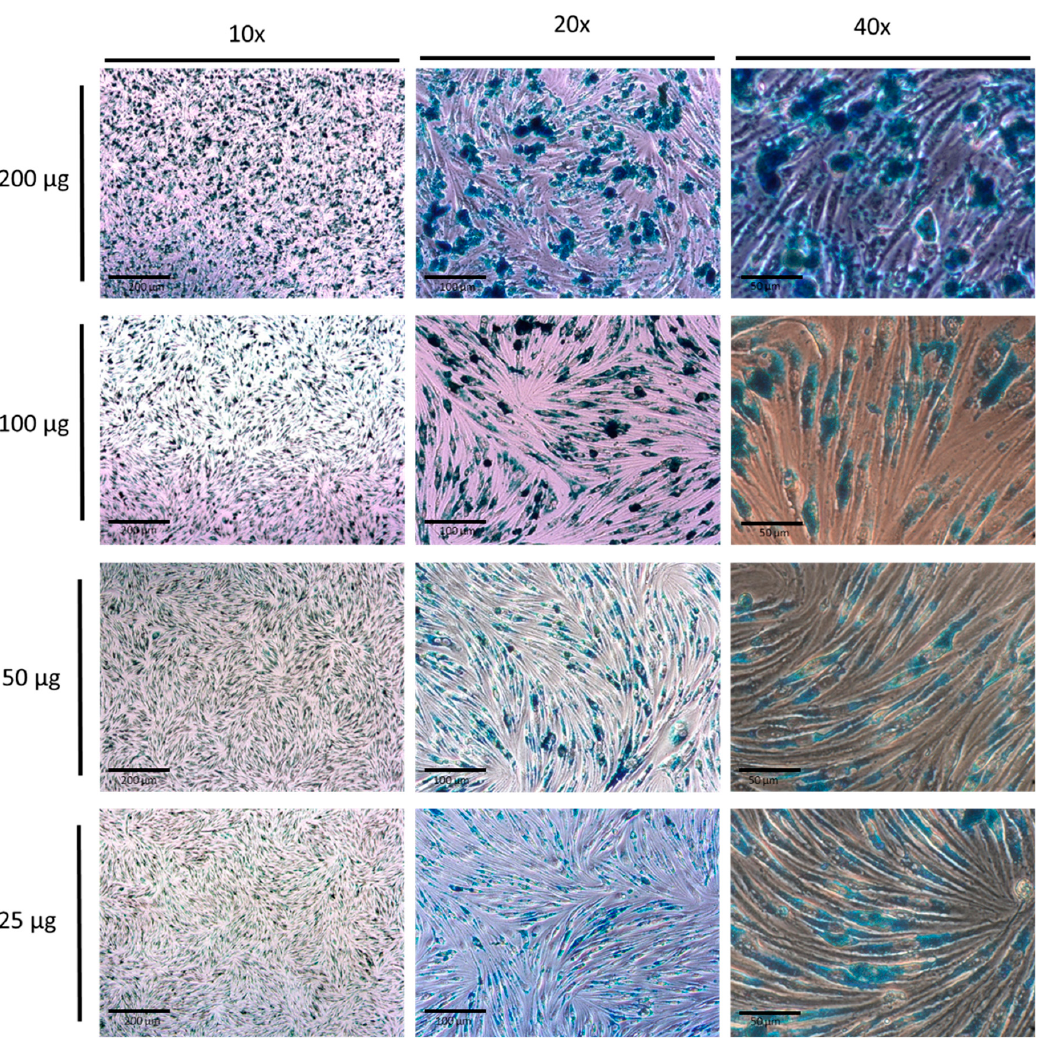
Figure 13. Prussian Blue stain of HMMSN hybrid magnetic mesoporous nanorods after 24 h of incubation with Bend.3 endothelial cells. Scale bars: 10× = 200 µm, 20× = 100 µm, and 40× = 50 µm.